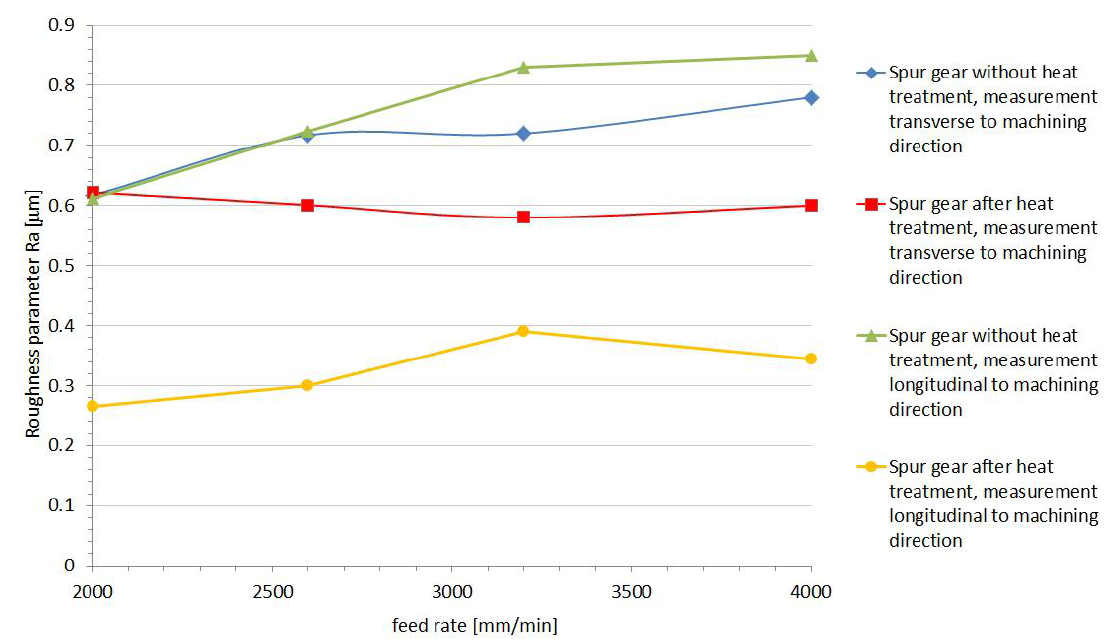
Figure 15. Results of the PVDA roughness measurement.